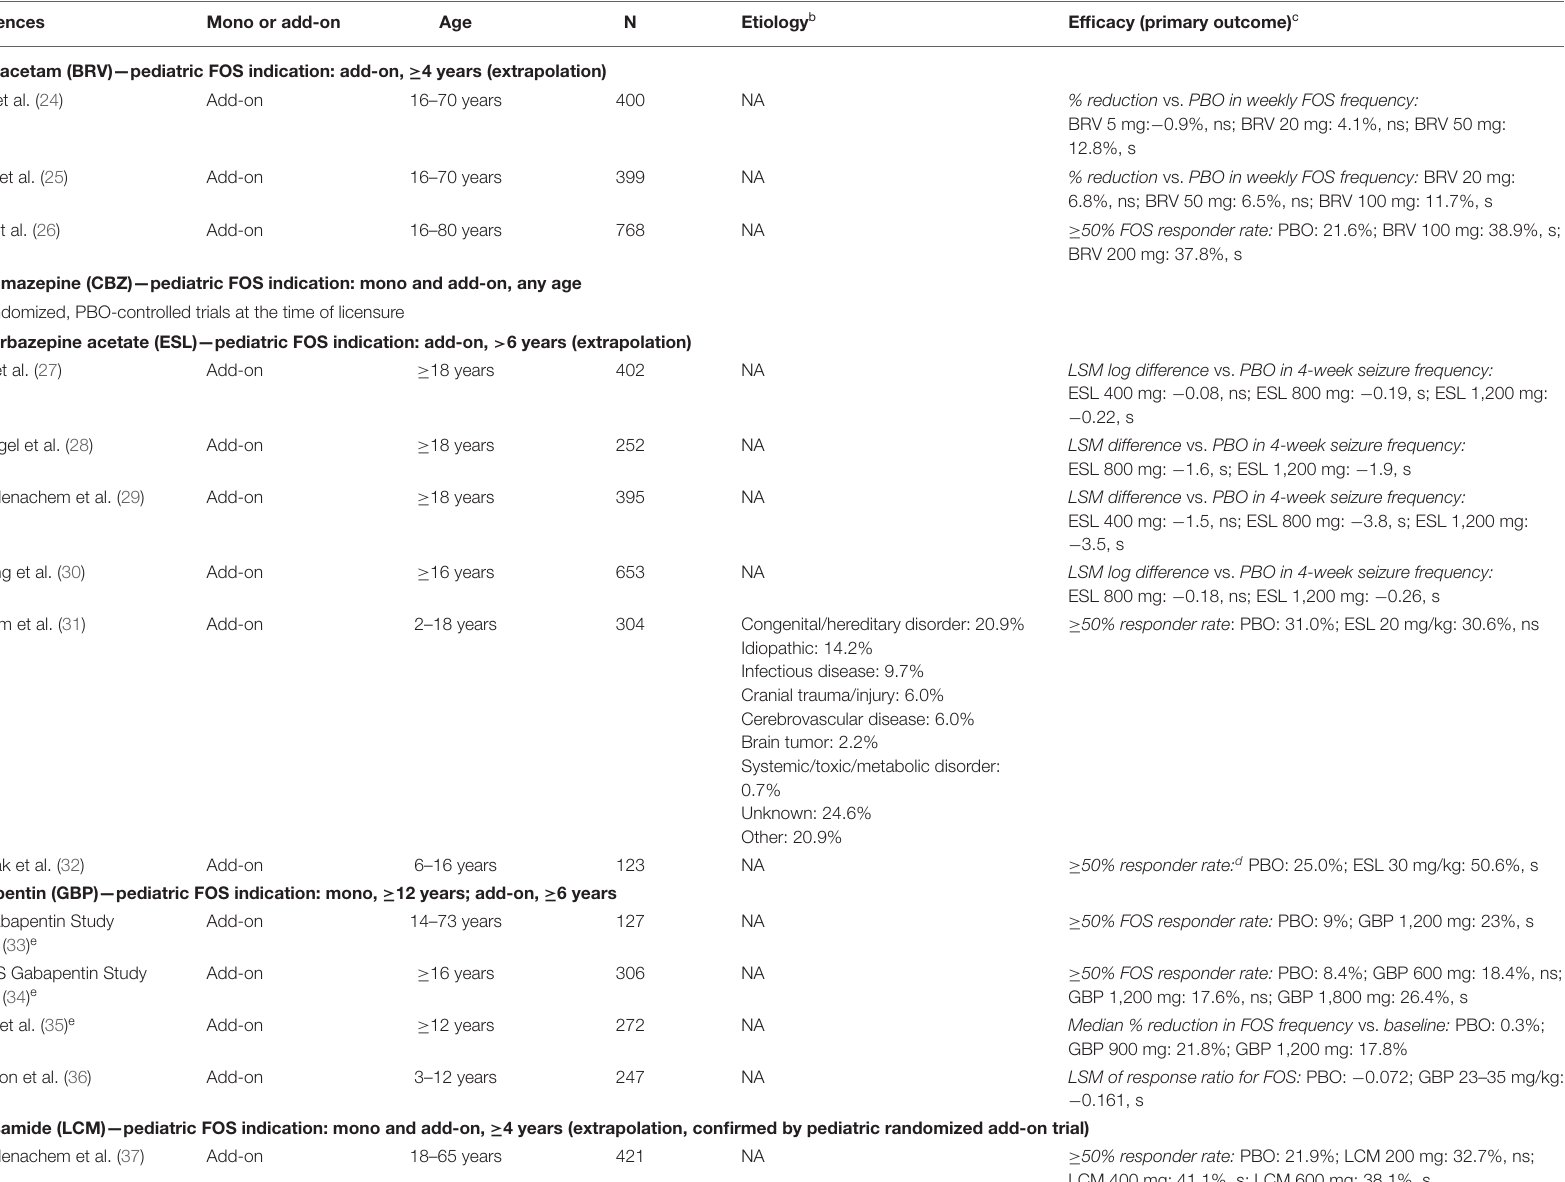
TABLE 1 | Antiseizure medication with a pediatric indication for focal-onset seizures in Europe and summary of efficacy evidence from randomized, placebo-controlled trials a used as basis for these indications.